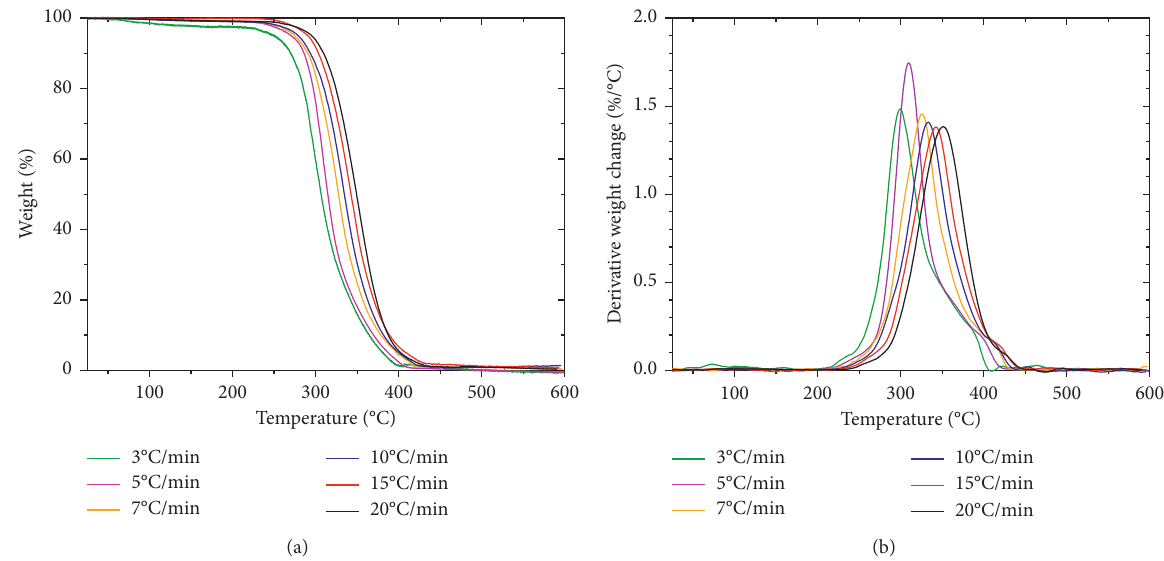
Figure 2: (a) TGA curves for sample PNVP- co -P Η MA 20–80 under different heating rates. (b) Derivative weight loss with temperature for sample PNVP-co-P Η MA 20–80 under different heating